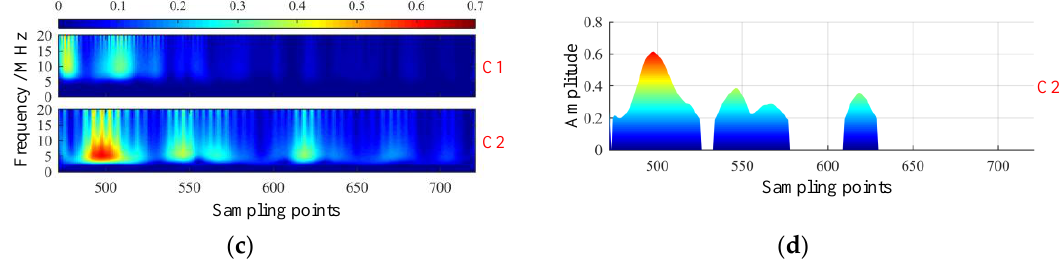
Figure 9. Modes extracted of the experimental signal via variational mode decomposition. ( a ) Intrinsic mode functions; ( b ) spectrums of intrinsic mode functions; ( c ) GST spectrums of intrinsic mode functions; ( d ) projection of GST spectrum of C2.